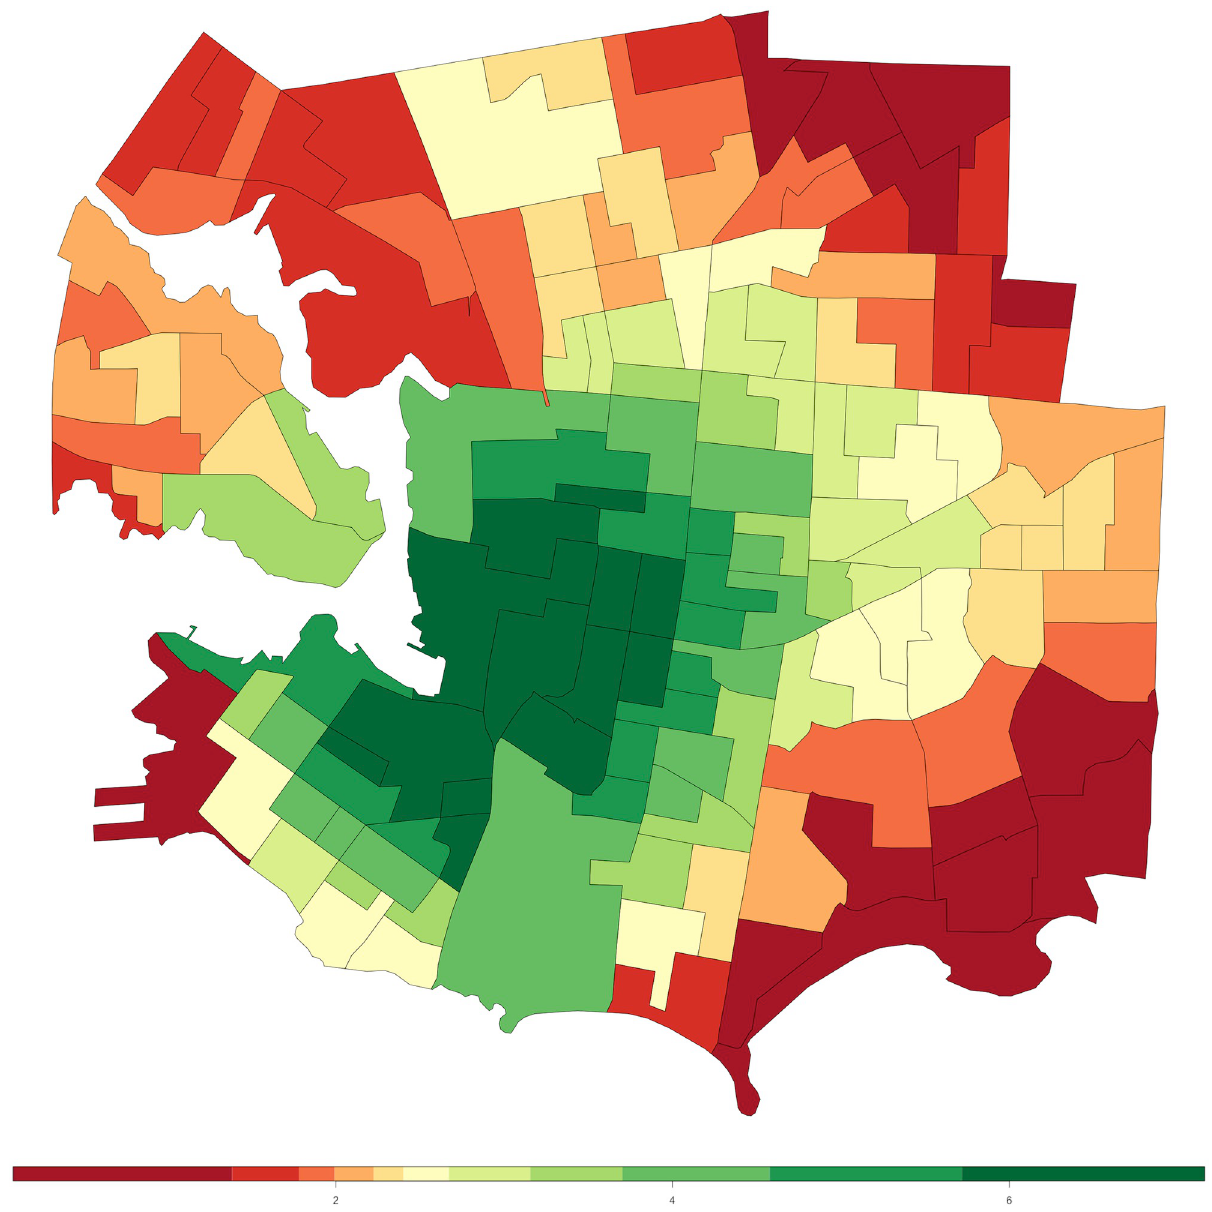
Fig 1. Can–ALE walkability score for Victoria, BC. Can–ALE scores are assigned by dissemination area. Dark green shows most walkable while dark red shows least walkable. (generated through RStudio [31] Version 1.2 from